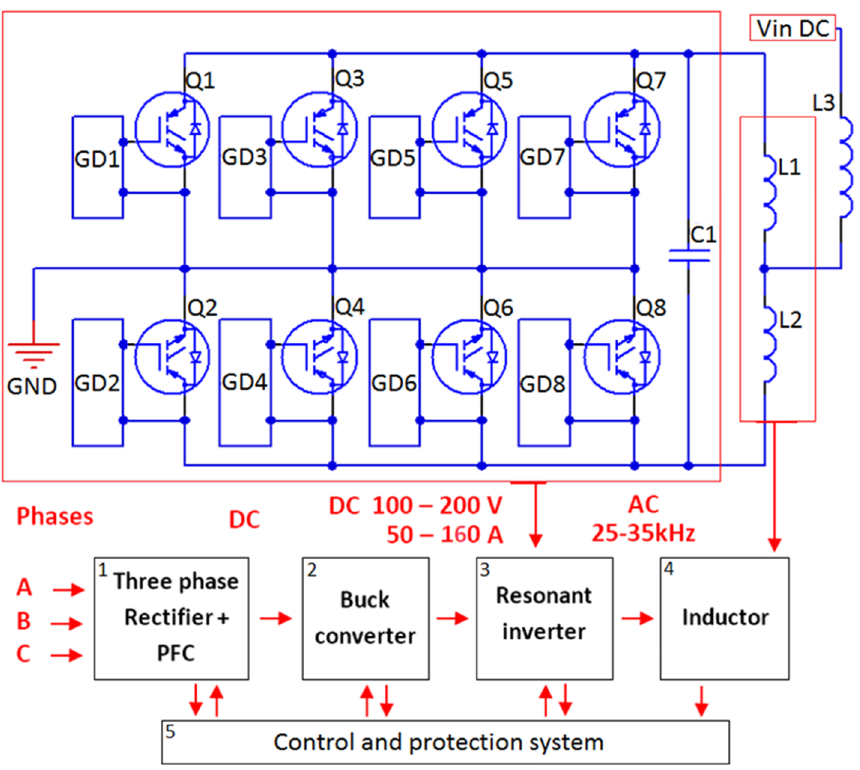
Figure 1. The electronic circuit of the proposed inverter for induction heating crucible melting furnace. Q1-Q8 IGBT transistors; GD1-GD8 gate drivers; C1, L1, L2 resonance tank; L3 induction heating inductor. A block diagram of the entire system for induction heating.